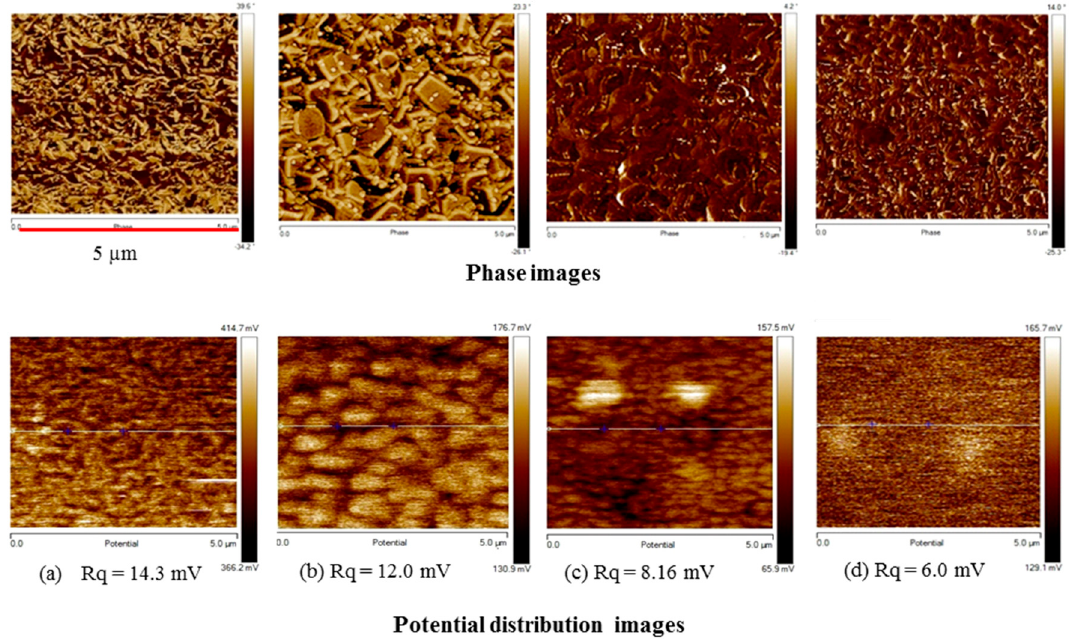
Figure 9. AFM phase (upper panel) and potential mapping (lower panel) images of graphene ‐ TiO 2 films with various TiO 2 contents (TS:GD volume ratio), annealed at 150 °C. ( a ) spin ‐ SVPT graphene; ( b ) spin ‐ SVPT graphene ‐ TiO 2 at TS:GD = 1:9; ( c ) spin ‐ SVPT graphene ‐ TiO 2 at TS:GD = 1:4; and ( d ) SVASC graphene ‐ TiO 2 at TS:GD = 1:4. Note that letters ( a ) to ( d ) under each column in the lower panel refers to both phase (upper panel) and potential distribution (lower panel) images.